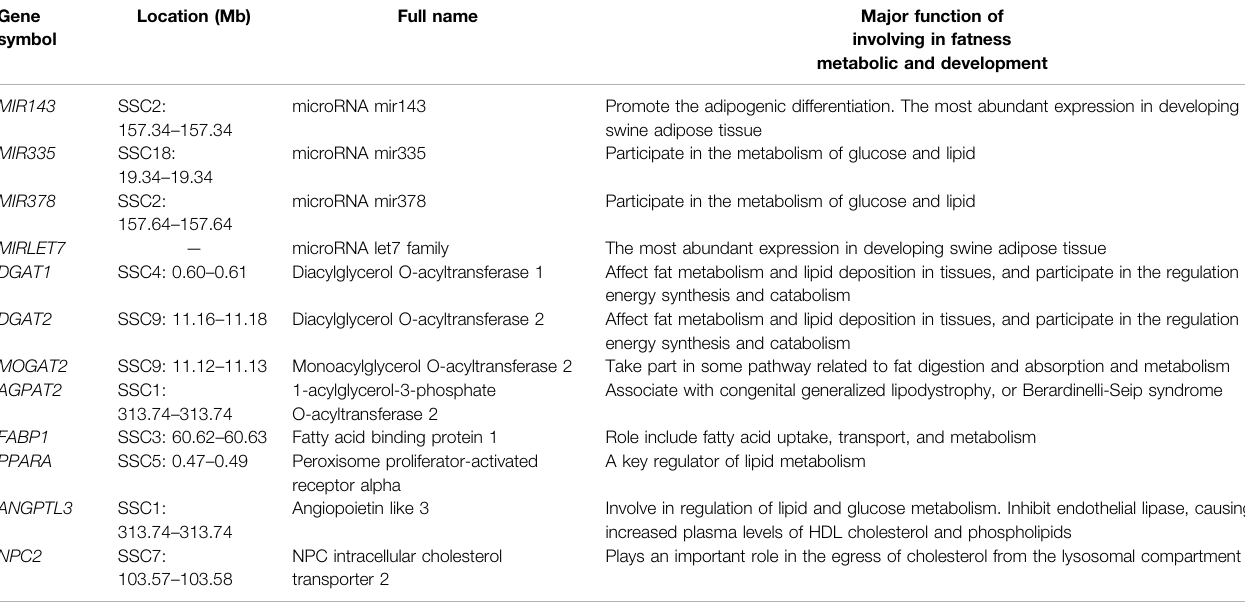
TABLE 5 | Some candidate genes overlapped with CNVRs involved fatness metabolic and development. Gene